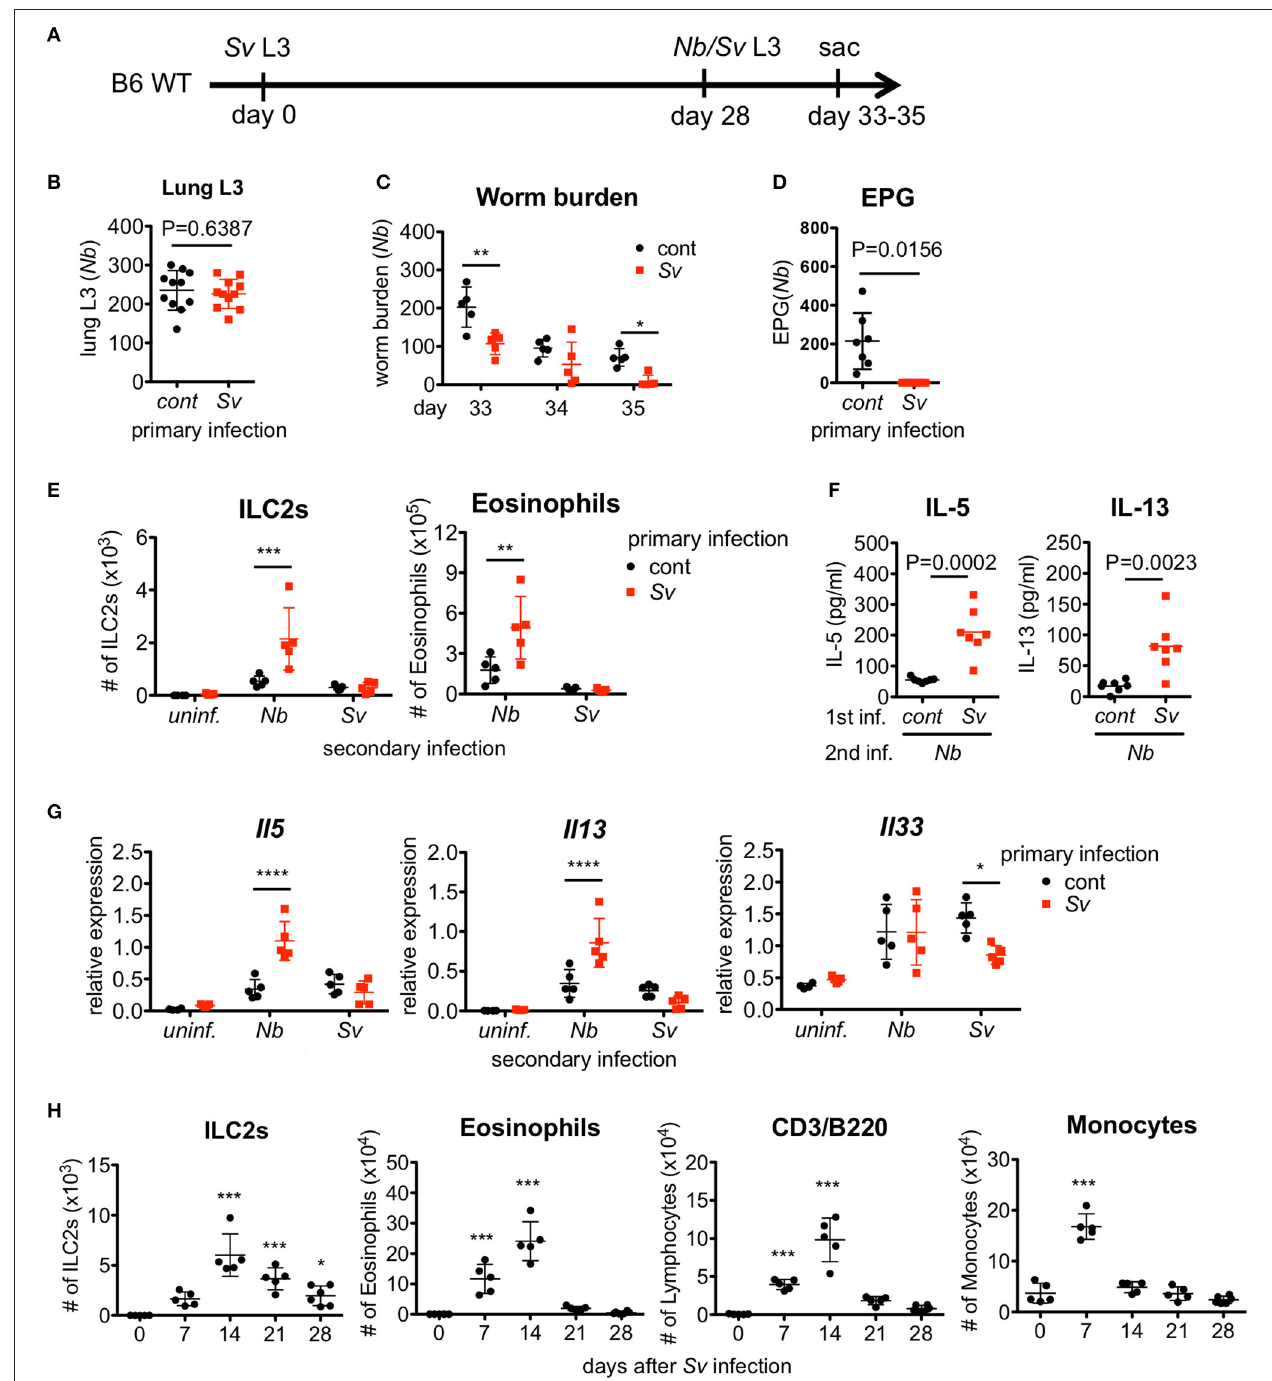
FIGURE 1 | Strongyloides venezuelensis -experienced mice develop an increased pulmonary inflammation and a resistance against Nippostrongylus brasiliensis infection. (A) Experimental workflow for sequential nematode infection. S. venezuelensis (Sv)-infected or uninfected mice were inoculated with 500 N. brasiliensis (Nb) L3 at day 28. B6; C57BL/6, WT; wild type, sac; sacrificed. (B) The number of lung stage N. brasiliensis larva. Two days after N. brasiliensis infection, migrating larva were isolated from the lungs and counted ( n = 11). cont, control (uninfected at day 0). Pooled data from two independent experiments are shown (Mean ± SD). (C) The numbers of worms in the intestine were counted at indicated days ( n = 5). (D) The numbers of eggs per gram feces (EPG) from each group at day 7 post- N. brasiliensis infection ( n = 7). (E–G) The numbers of eosinophils and ILC2s (E) , the amounts of IL-5 and IL-13 in the BALF (F) , and the Il5 , Il13 , and Il33 mRNA expression levels in the lungs as analyzed by Q-PCR (G) from day 35 are shown ( n = 4–5). uninf.; uninfected at day 28. Statistical analyses were conducted using two-way ANOVAs with Bonferroni post-hoc tests (B,E,G) , Wilcoxon matched-pairs signed rank tests, and two-tailed (C) or unpaired t-tests (F) . Data are representative of two independent experiments. (H) C57BL/6 WT mice ( n = 5–6) were infected with 5000 L3 S. venezuelensis at day 0. The numbers